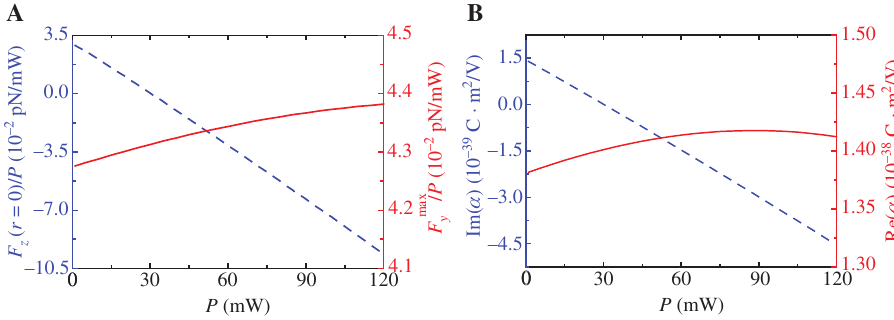
Figure 3: The incident power dependence of (A) the trapping forces and (B) the polarizability α at 420